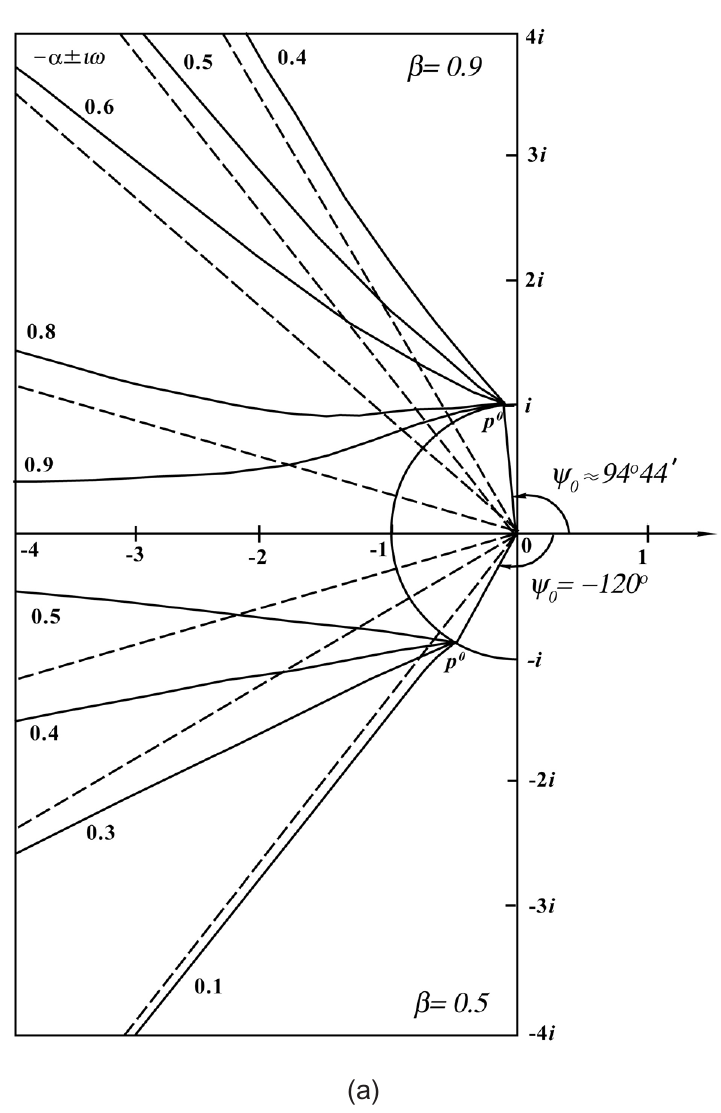
Fig. 2. The behavior of the complex conjugate roots for the fractional oscillator: (a) model (48a) and (b) model